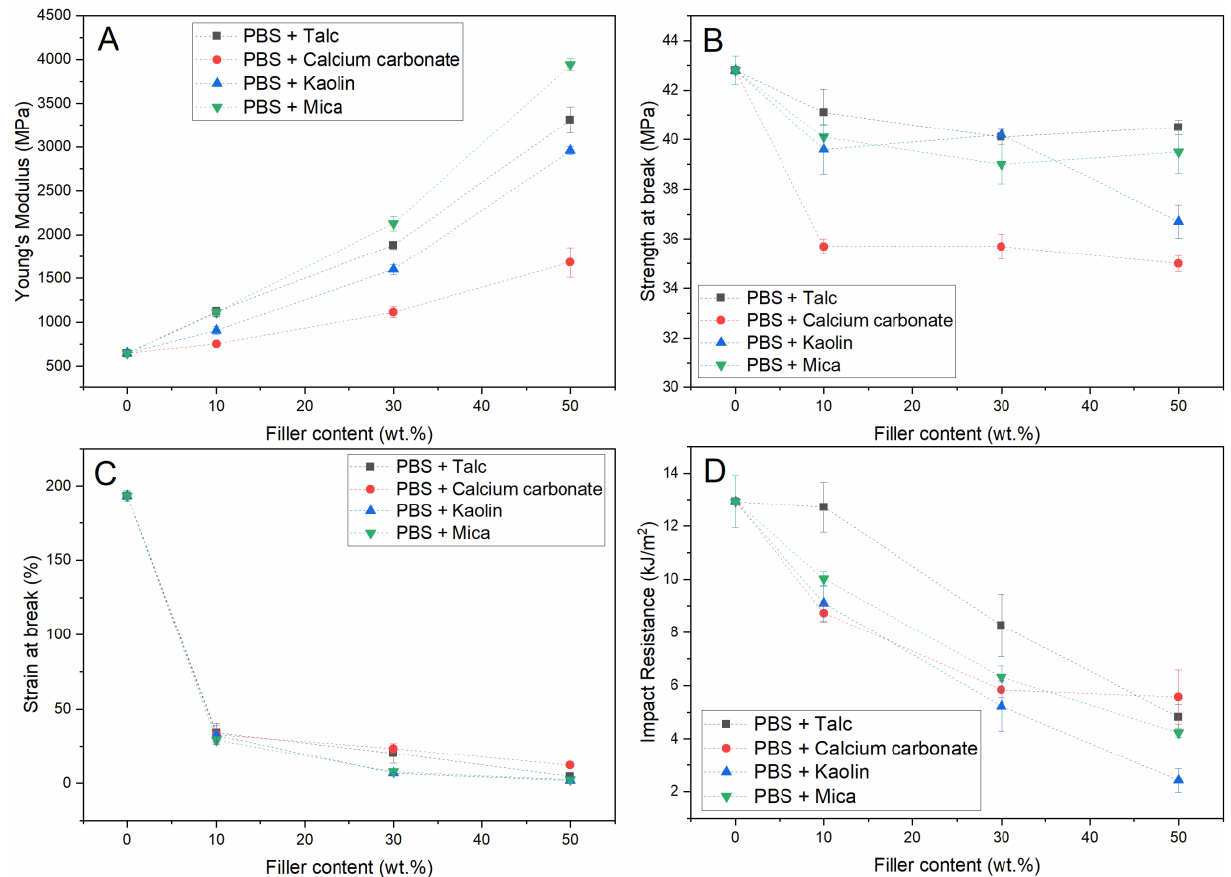
Figure 1. Mechanical properties (Young’s modulus ( A ), strength at break ( B ), strain at break ( C ), and notched impact resistance ( D )) of 4 different fillers in PBS.